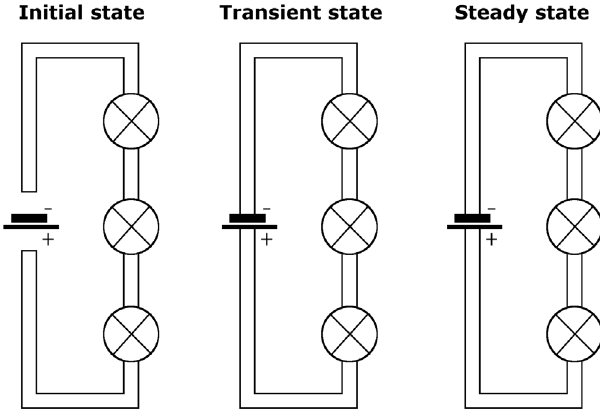
FIG. 13. Sample task in which the students use their dynamic model to qualitatively predict the voltage across two unequal light bulbs connected in series based on the change in electric pressure in the various parts of the